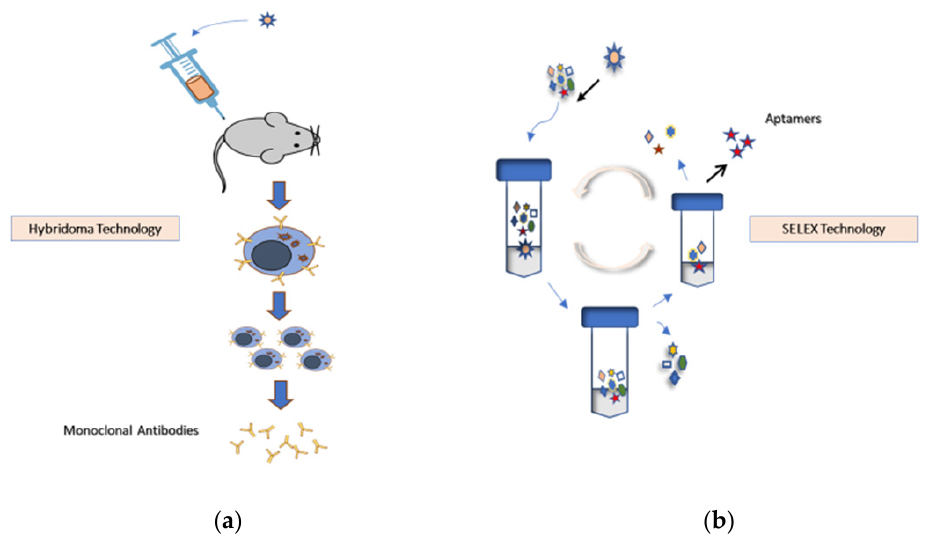
Figure 2. ( a ) Hybridoma technology is the fundamental method for producing identical antibodies (known as mAbs) specific to antigens of interest. It involves injecting animals (usually mice or rats) with an antigen that provokes an immune response for mAb production. This approach presents ethical considerations and restrictions related to infectious risks associated with animal use. Recom- binant mAb technology is an essential alternative to using animals for mAb generation and produc- tion [2]. ( b ) SELEX technology selects specific aptamers from random DNA, RNA, or peptide librar- ies without sacrificing animals.